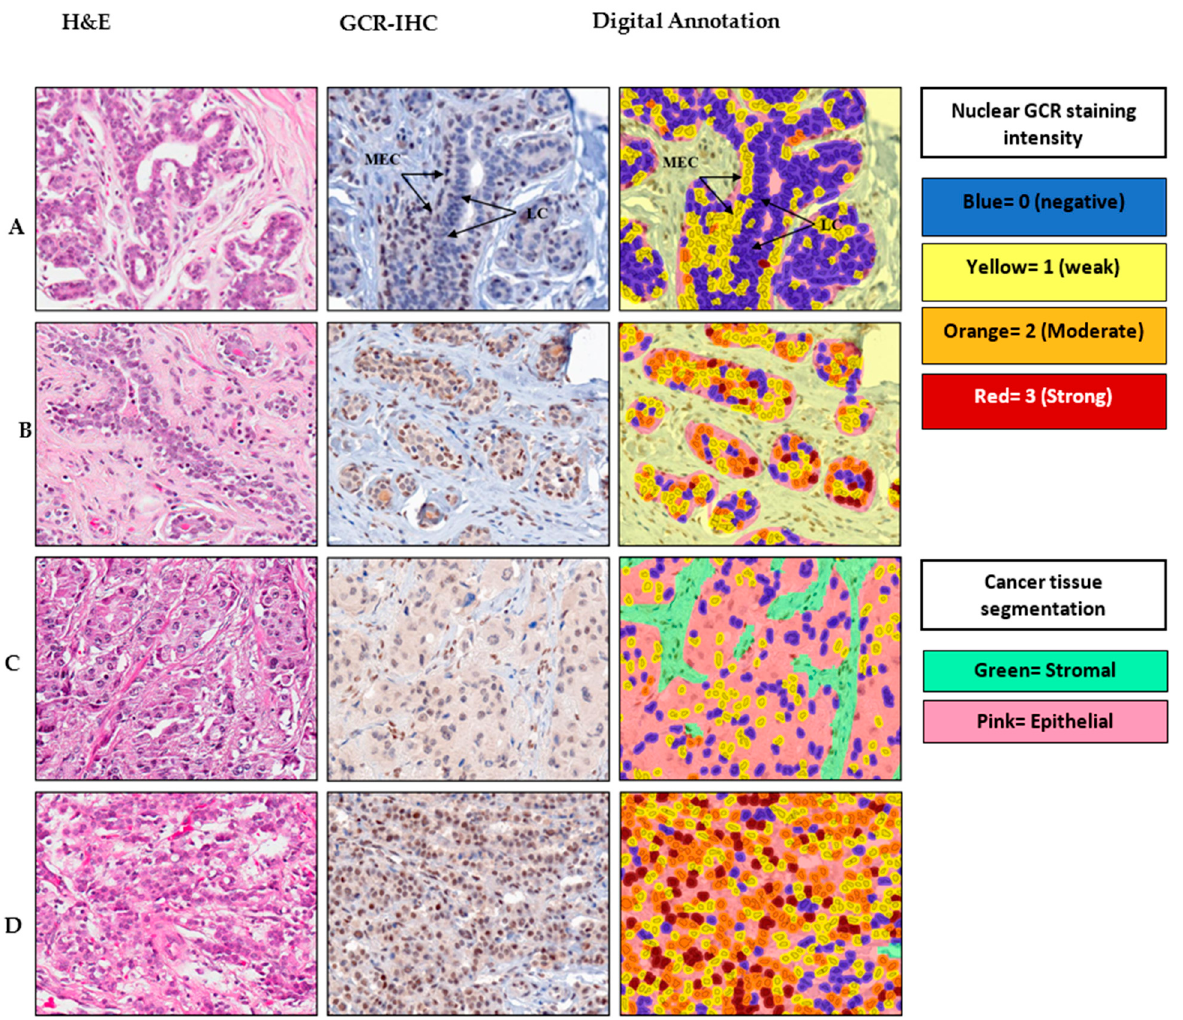
Figure 1. Immunohistochemical staining and digital output images for glucocorticoid receptor (GCR) in representative cases. For each case, H&E and the corresponding anti-GCR IHC image and digital analysis output are shown. ( A ) Normal breast tissue, ( B ) fibroadenoma, ( C ) ductal carcinoma and ( D ) lobular carcinoma. LC, luminal cells; MEC, myoepithelial cells .